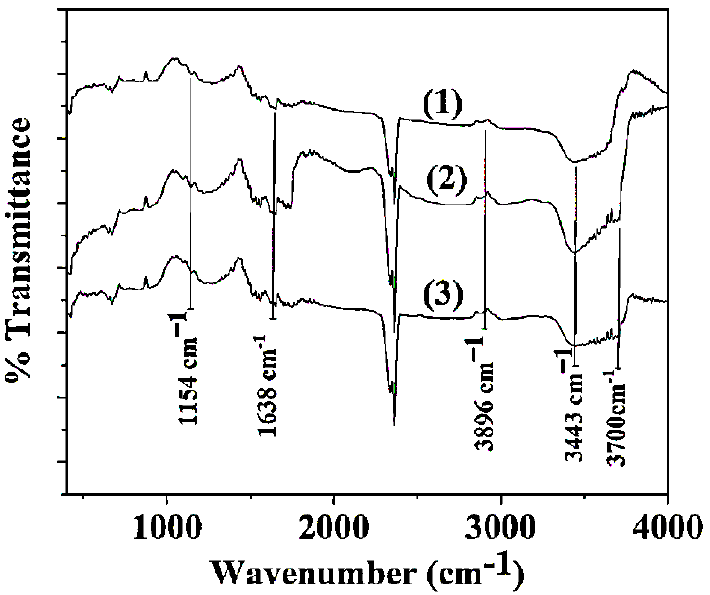
Figure 3. FTIR spectras of neat CS/PVOH film (1) as well as CS/PVOH/HNT (2), and CS/PVOH/TO@HNT (3) films for